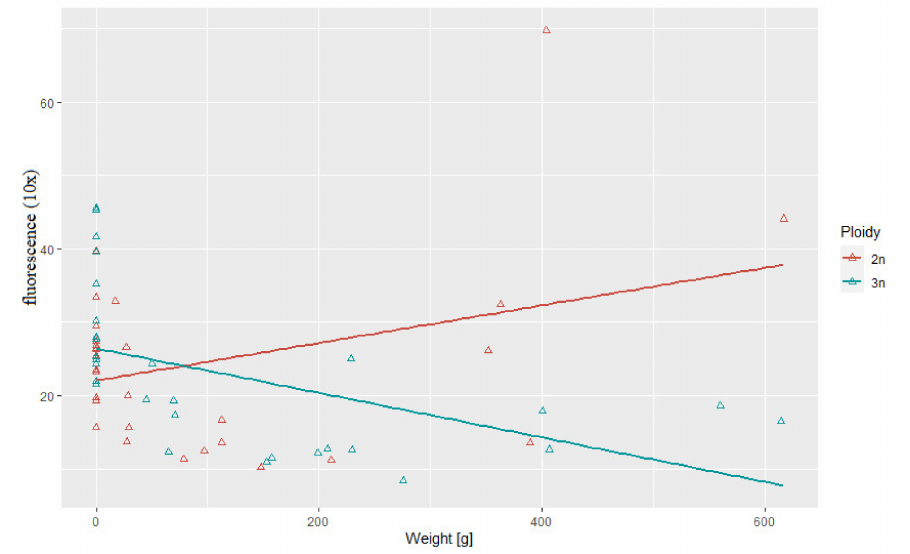
Figure 4. Relationship between telomere length-related fluorescence and body weight observed in examined triploid ( r 2 = 0.52, p > 0.05) and diploid ( r 2 = 0.34) rainbow